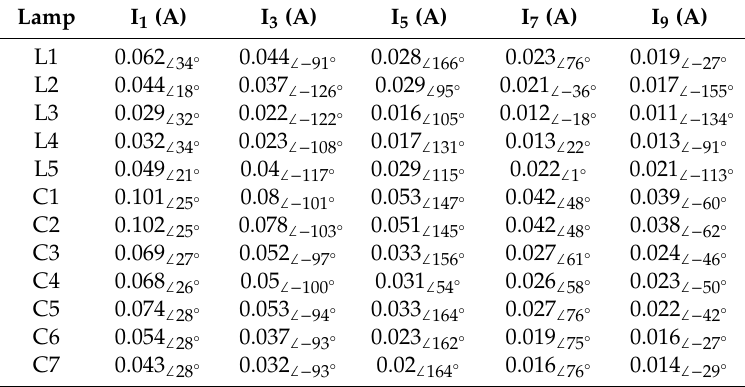
Table 4. Measured values for the fundamental current and the 3rd, 5th, 7th and 9th harmonic currents for the twelve lamps.